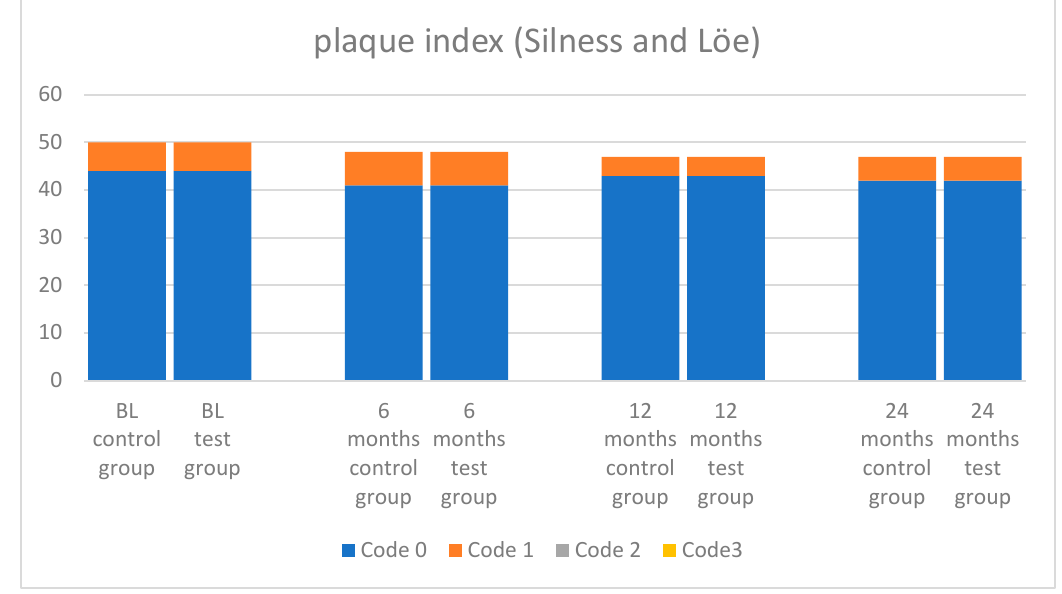
Figure 8. Plaque index (Silness and Löe) [22,23] .